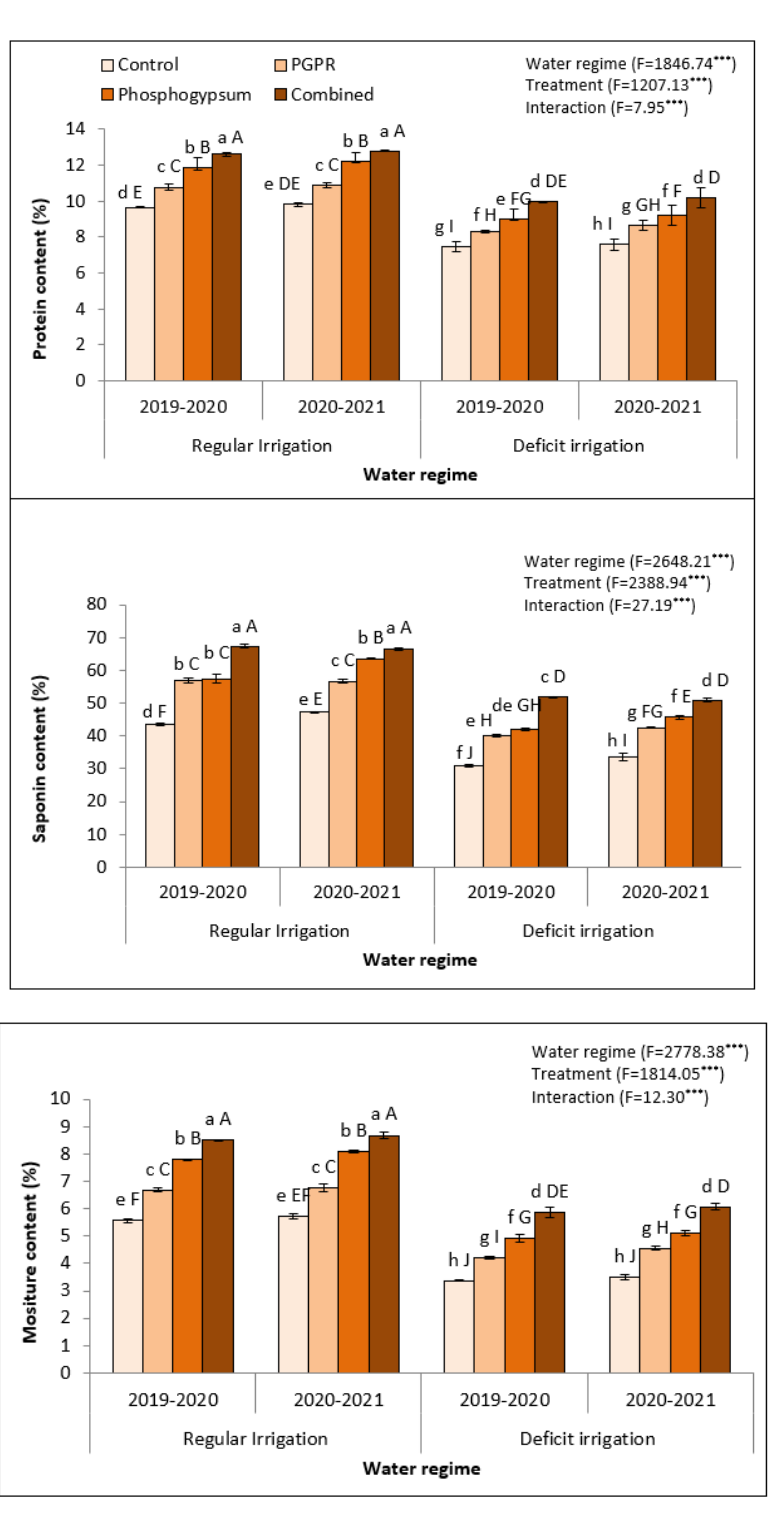
Figure 4. Variations in seed protein, saponin, and moisture contents in quinoa ( Chenopodium quinoa ) exposed to different water regimes in the presence of singular or dual application of PGPR and phosphogypsum during two growing seasons (2019–2020 and 2020–2021). Different lowercase letters on the same columns of the same season are significant according to the Tukey’s test ( p ≤ 0.05) and different uppercase letters are significant regardless of the growing season according to the Tukey’s test ( p ≤ 0.05). Data are Means ± SD and n = 3. *** denotes significance at p ≤